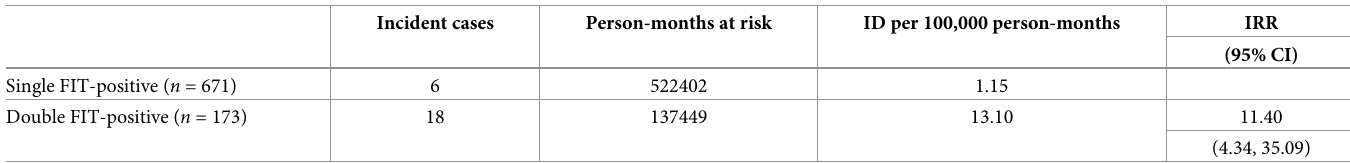
Table 3. Incidence density of colorectal cancer, and incidence rate ratio, between single FIT-positive and double FIT-positive colonoscopy-compliant